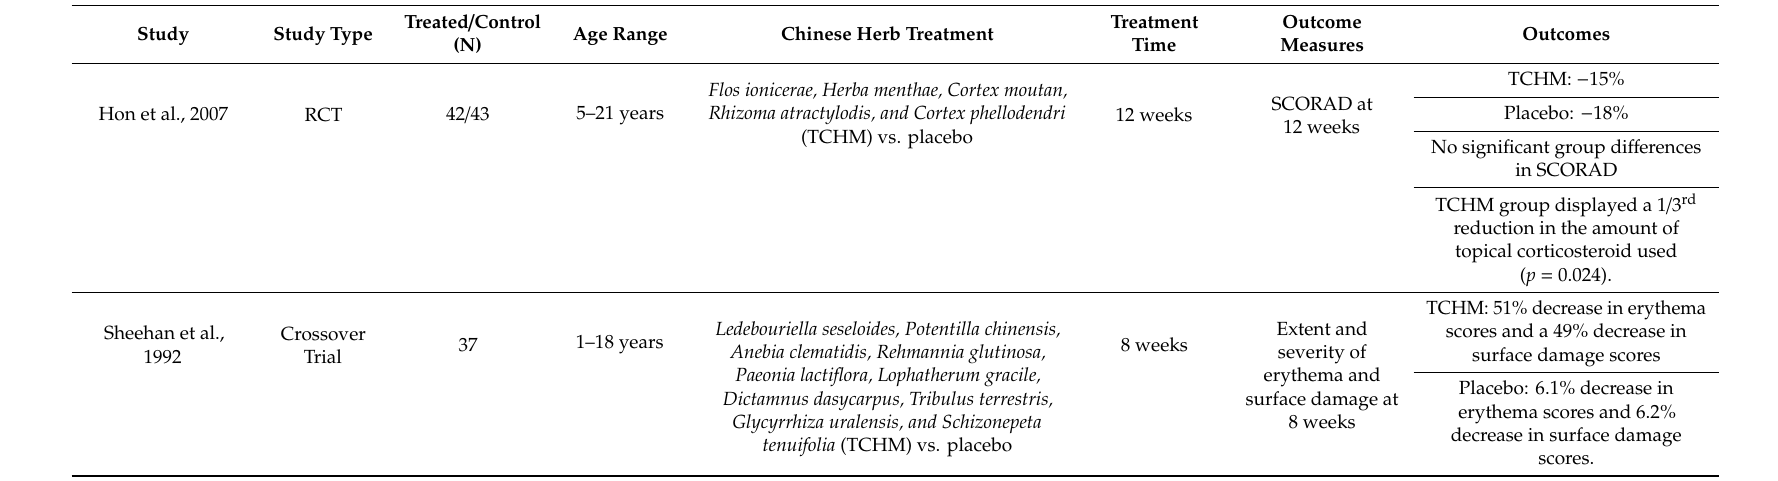
Table 4. Chinese herbal treatments for pediatric atopic